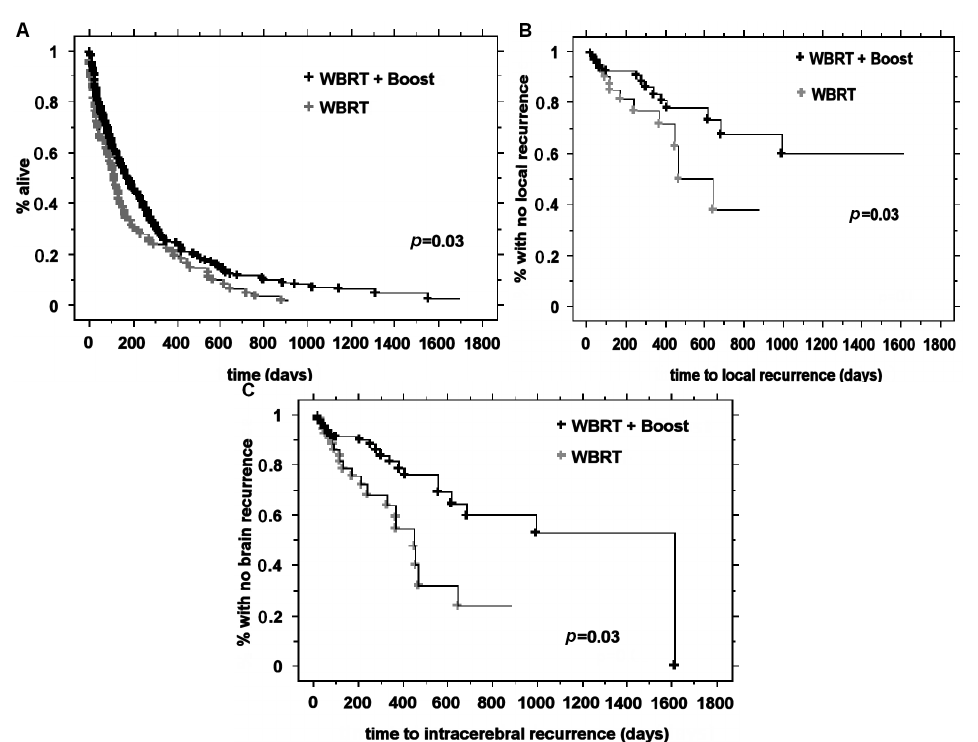
Figure 1. Comparison of whole brain radiation therapy (WBRT) alone and WBRT